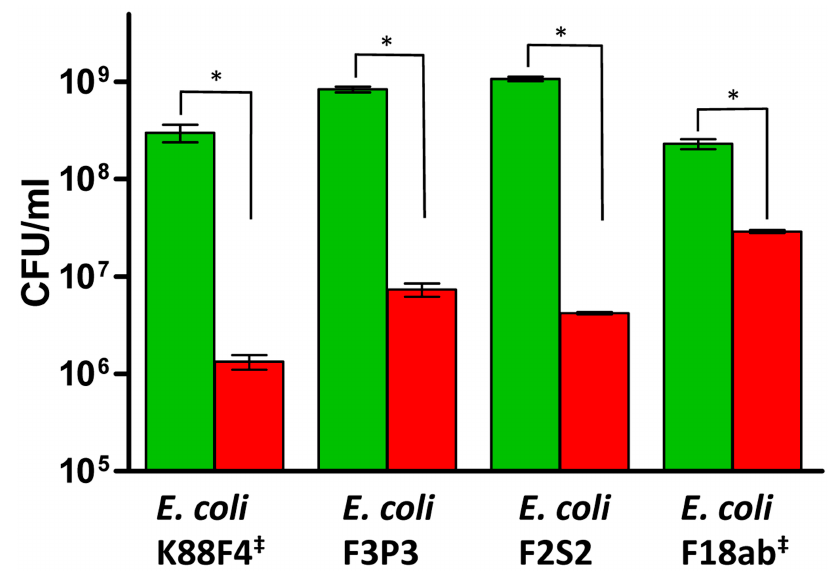
Figure 2. Kill effect of nisin in combination with cinnamaldehyde and EDTA against E. coli strains of swine origin. Kill assay performed over a defined 3 h period with E. coli K88F4 in the presence of nisin (33 µ g/mL) + cinnamaldehyde (125 µ g/mL) + EDTA (1%) and untreated control (Green), E. coli F3P3 in the presence of nisin (33 µ g/mL) + cinnamaldehyde (125 µ g/mL) + EDTA (2%) (Red) and untreated control (Green), E. coli F2S2 in the presence of nisin (33 µ g/mL) + cinnamaldehyde (125 µ g/mL) + EDTA (1%) EDTA 2% (Red) and untreated control (Green), E. coli F18ab in the presence of nisin (33 µ g/mL) + cinnamaldehyde (125 µ g/mL) + EDTA (0.25%) (Red) and untreated control (Green). Asterisks rating of * indicates statistically significant differences between groups ( p ≤ 0.05). ‡ denotes ETEC strains.